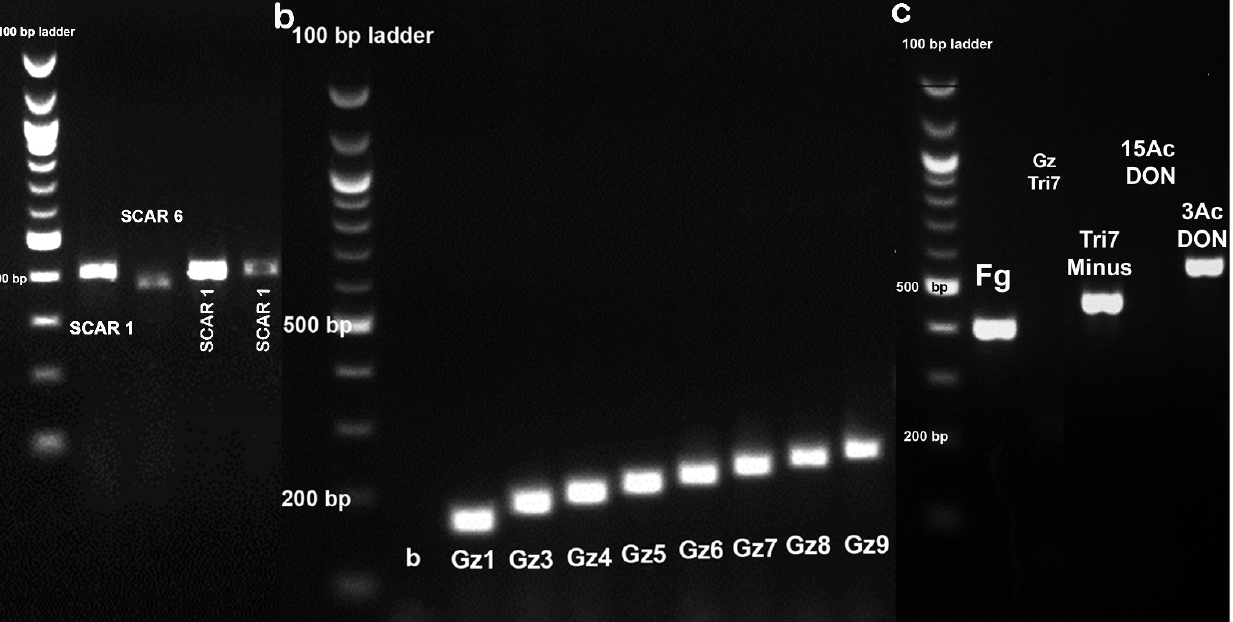
Figure 3. Diversity of Fg16 target and Tri7 genes. ( a ) SCAR (Sequence characterized amplified region) analysis of the F. graminearum clade with the Fg16F/R primer pair identifying SCAR 6 and SCAR 1 PCR products; ( b ) Tri7 gene diversity in the F. graminearum population: b—blank; Gz1—PCR product of the Tri7 allele with one 11 bp repeat; Gz3—PCR product of the Tri7 allele with three 11 bp repeats; Gz4, Gz5, Gz6, Gz7, Gz8, and Gz9—PCR products of Tri7 alleles with four, five, six, seven, eight, and nine 11 bp repeats, respectively; ( c ) trichothecene genotyping of F. graminearum s. stricto based on the Tri7 deletion: Fg16— PCR product of the Fg16F/R primer pair; GzTri7 —the GzTri7f1/r1 primer pair for the Tri7 gene yielded no PCR product; tri7Minus — PCR product of the Minus Tri7F/R primer pair confirming the deletion of the Tri7 gene; 15-AcDON— the Tri315F/R primer pair for 15 -AcDON yielded no PC R product; 3 -AcDON— PCR product of the Tri303F/R primer pair for 3 -AcDON.